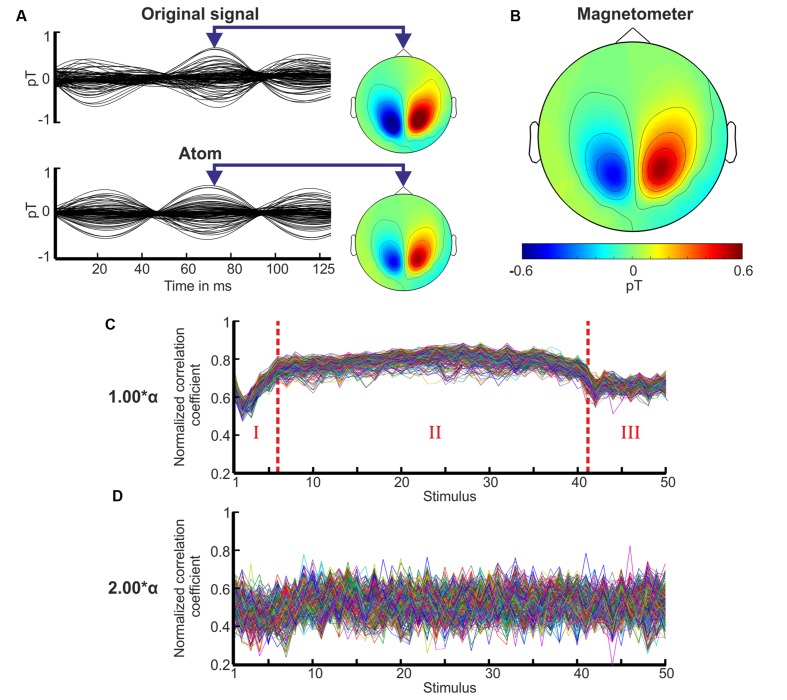
Approximation, topography of the reference atom, and correlation coefficient sequence of the TMP atoms.
(A) The original measurement of the 20th stimulus is shown for the whole period of 125 ms for the stimulation with 1.00∗α of volunteer P10. Underneath its approximation by a TMP atom is displayed. The topographies depict the field distributions of the magnetometers using the same scale as in (B). (B) The topography of the magnetometers is plotted for the resulting reference atom of volunteer P10 at the same time as in (A). (C) The mean correlation coefficient sequence for each channel over all subjects is depicted for the stimulus periods 1–40 and 10 periods after the end of stimulation (x-axis) for the flicker stimulation with 1.00∗α. The coefficients are normalized in the range from 0 to 1. Three characteristic phases are observed marked by dotted red lines and numbers: phase I increase, phase II plateau, and phase III decrease. (D) Mean correlation coefficient sequence for each channel over all subjects for the stimulation with 2.00∗α over the same stimulus range as in (C).